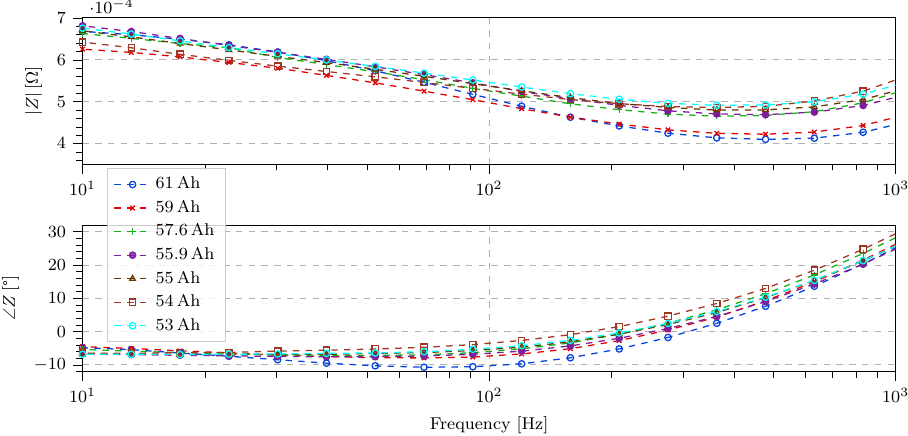
Figure 3. Bode plot of cell C1’s impedance with ageing. Measurements performed at 50% SoC and 25°C. Legend shows the measured maximum available capacity. For clarity purposes, only the segment with most significant differences is